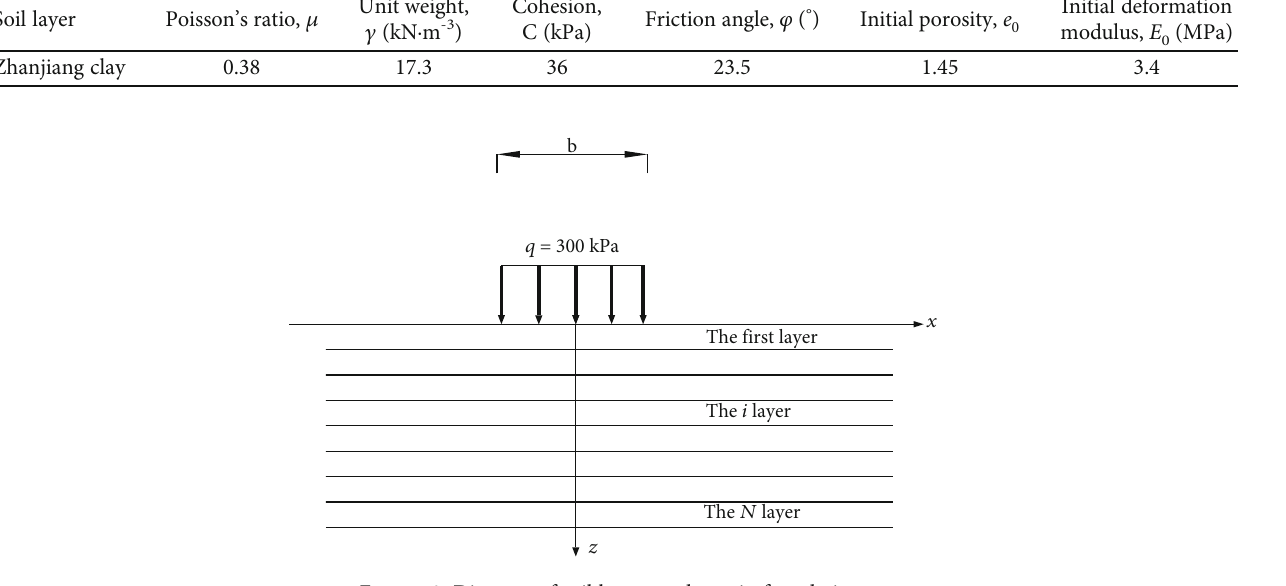
Figure 2: Diagram of soil layers under strip